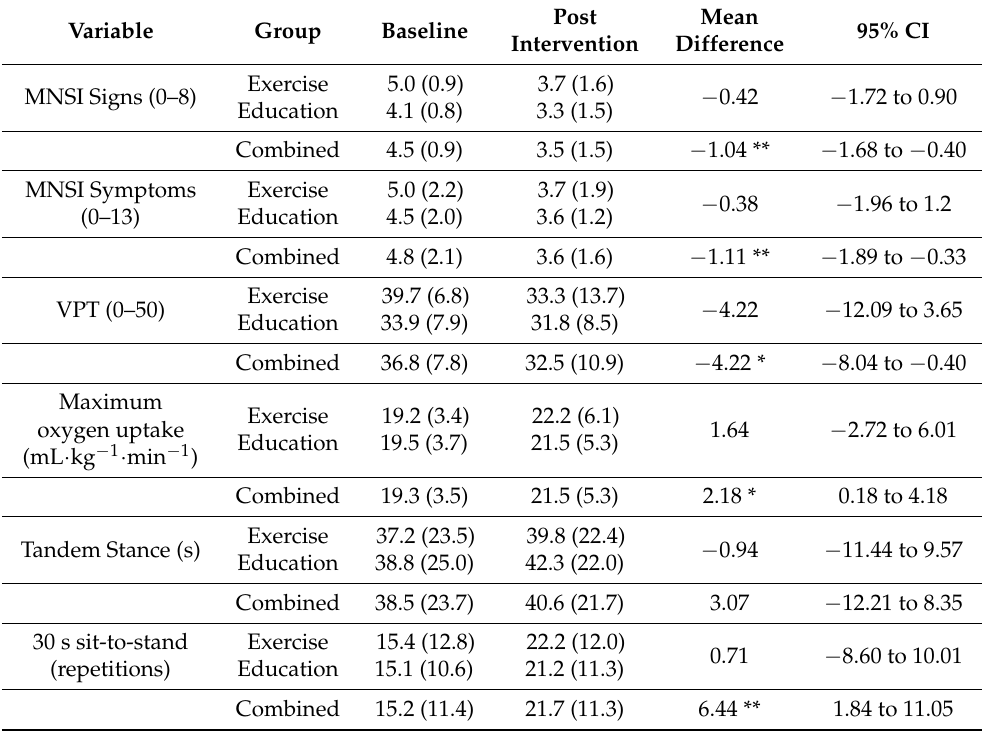
Table 2. Mean (SD) and 95% confidence interval baseline and post intervention outcome scores for the combined cohort and the exercise and intervention